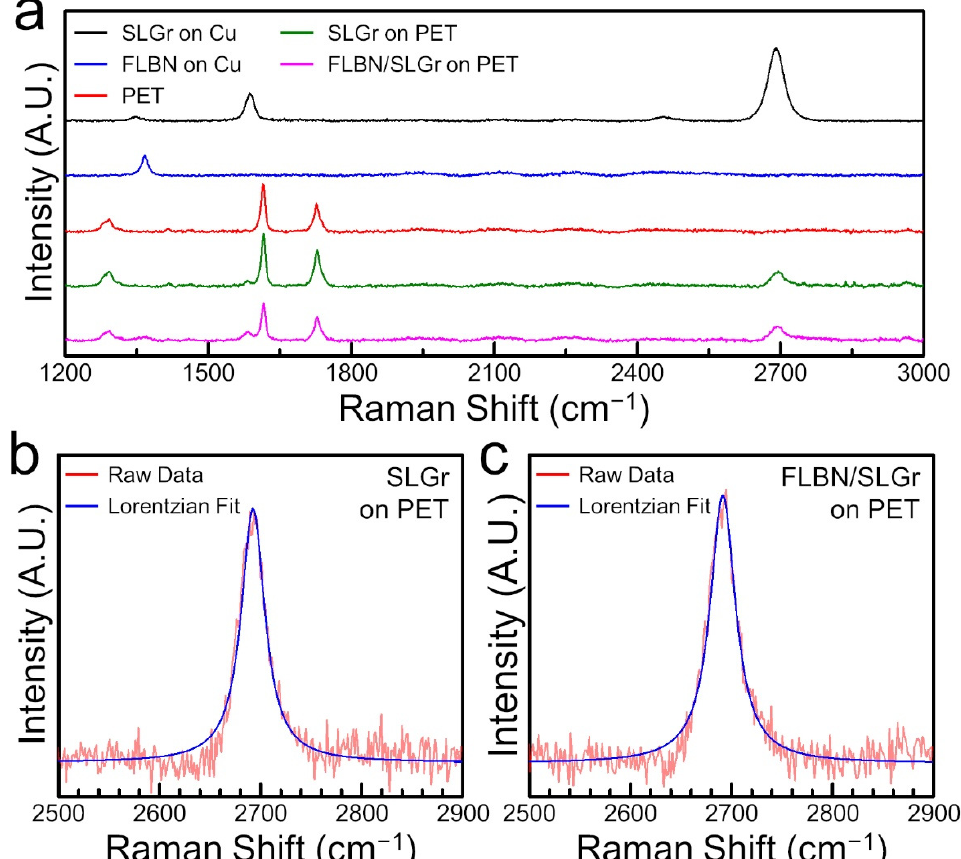
Figure 4. Raman spectroscopy characterization of the prepared SLGr and FLBN/SLGr heterostruc- tures. ( a ) Raman spectral plot of a transferred SLGr on PET substrates (blue color), Raman plot of SLGr on Cu before transferring (black color), and that of PET substrate alone (red color). ( b ) Raman spectral plot of transferred FLBN/SLGr on PET substrates (magenta color), Raman plots of SLGr on Cu (black color) and FLBN on Cu (blue color) before transferring onto PET substrates, and PET substrate alone (red color). ( b , c ) Individual Raman spectral plots of 2D bands of SLGr on PET and FLBN/SLGr on PET (blue color) (red lines in ( b , c ) represent the Lorentzian curve fits).